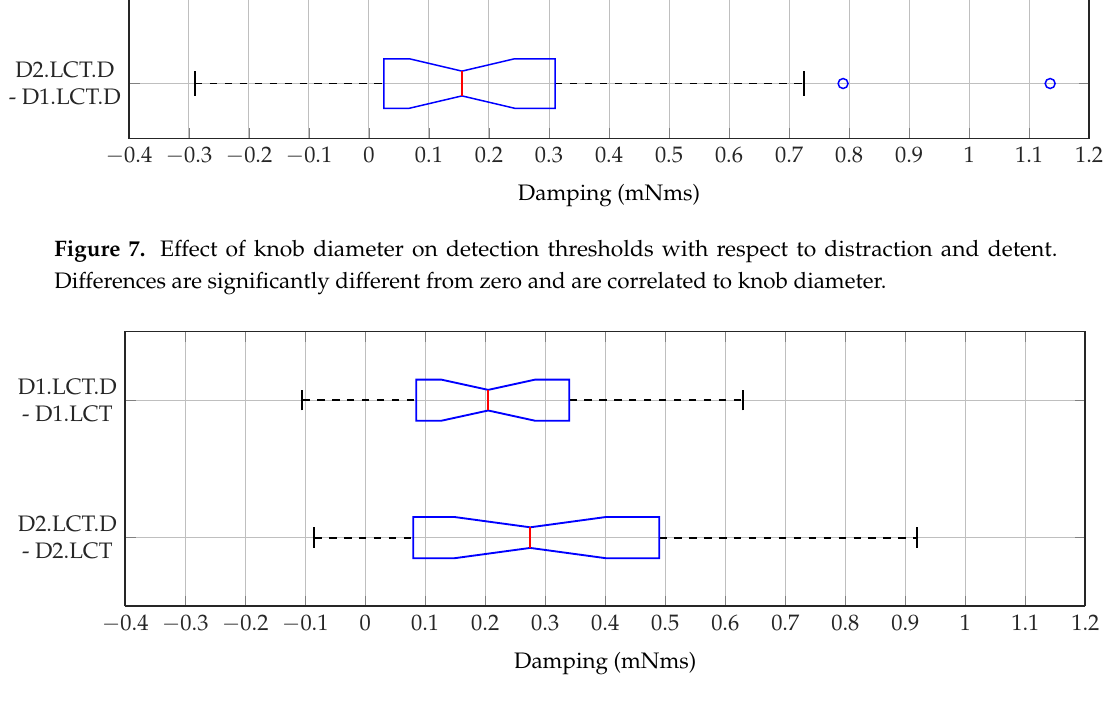
Figure 8. Effect of detent condition on detection thresholds with respect to knob diameter. Differences are significantly different from